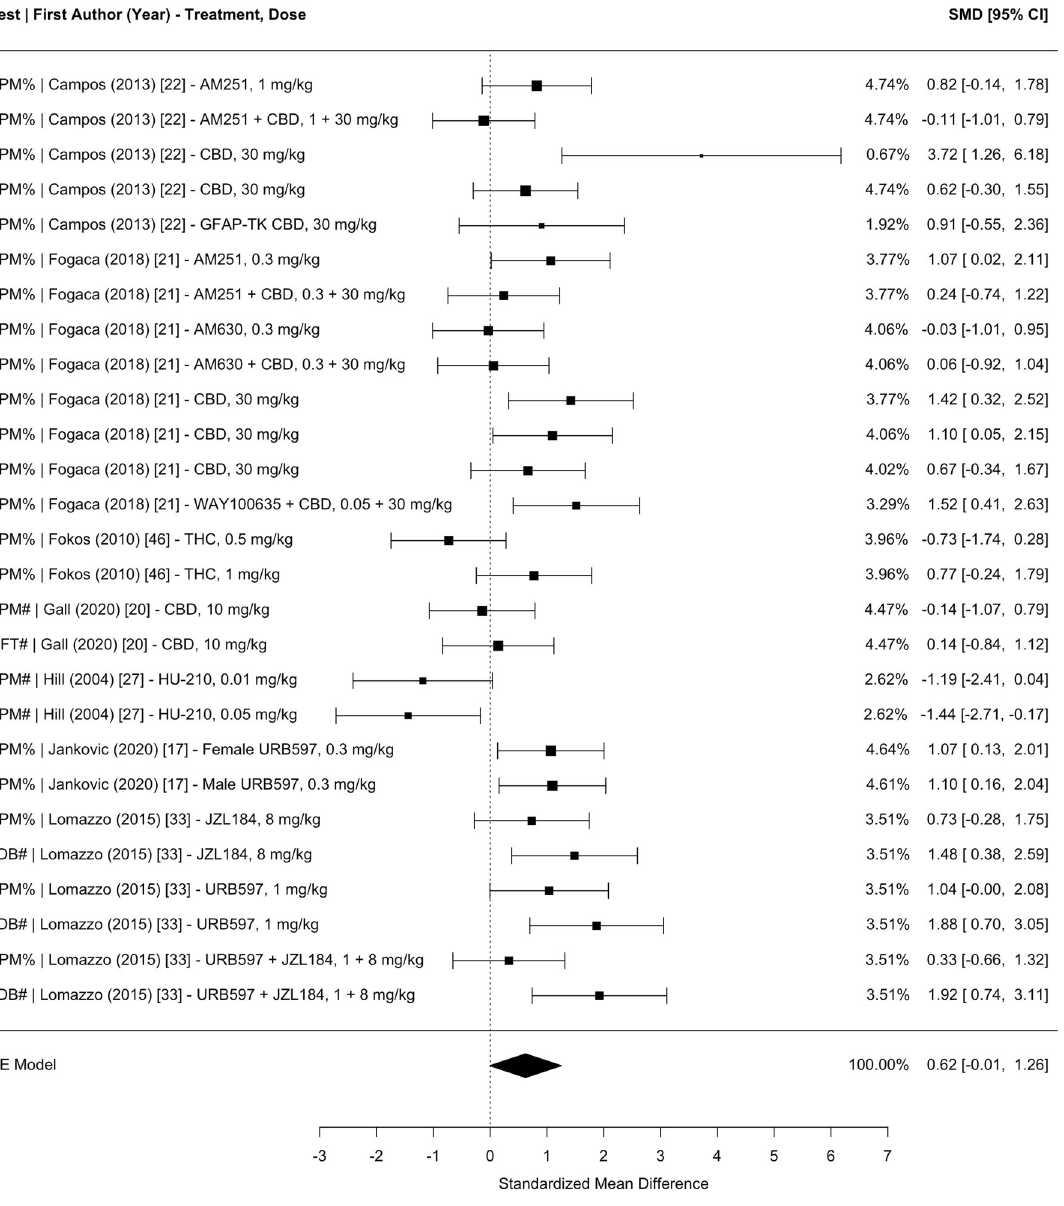
Fig. 6 Meta-analysis of studies investigating the effect of CB administration on exploration anxiety (i.e., % or # of entries into the anxiogenic context) in CUS. EPM elevated plus-maze, OFT open fi eld test, LDB light dark box test, SMD standardized mean difference, CI con fi dence interval, CBD cannabidiol, GFAP-TK glial fi brillary acidic protein thymidine kinase transgenic mice, THC